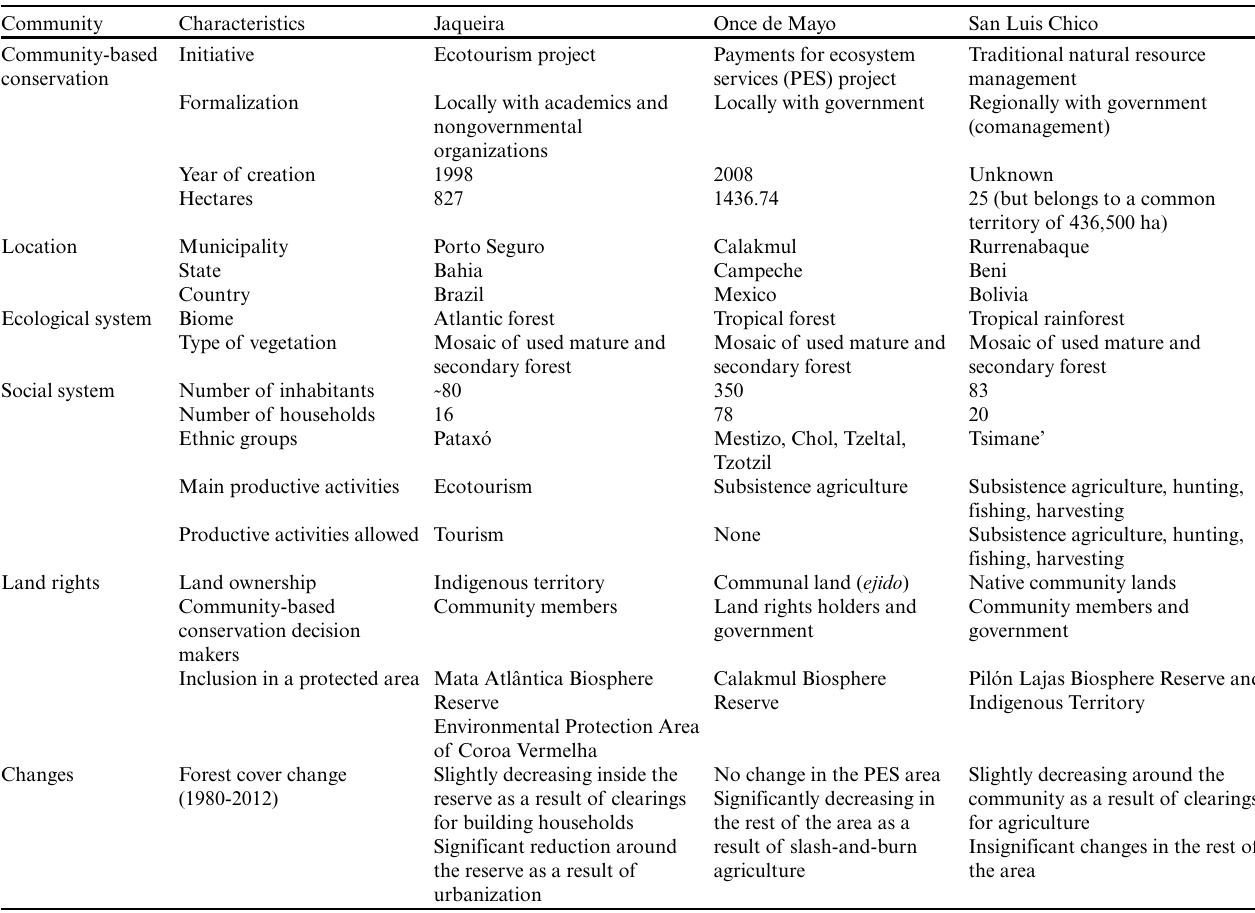
Table 1 . Social-ecological characteristics of selected